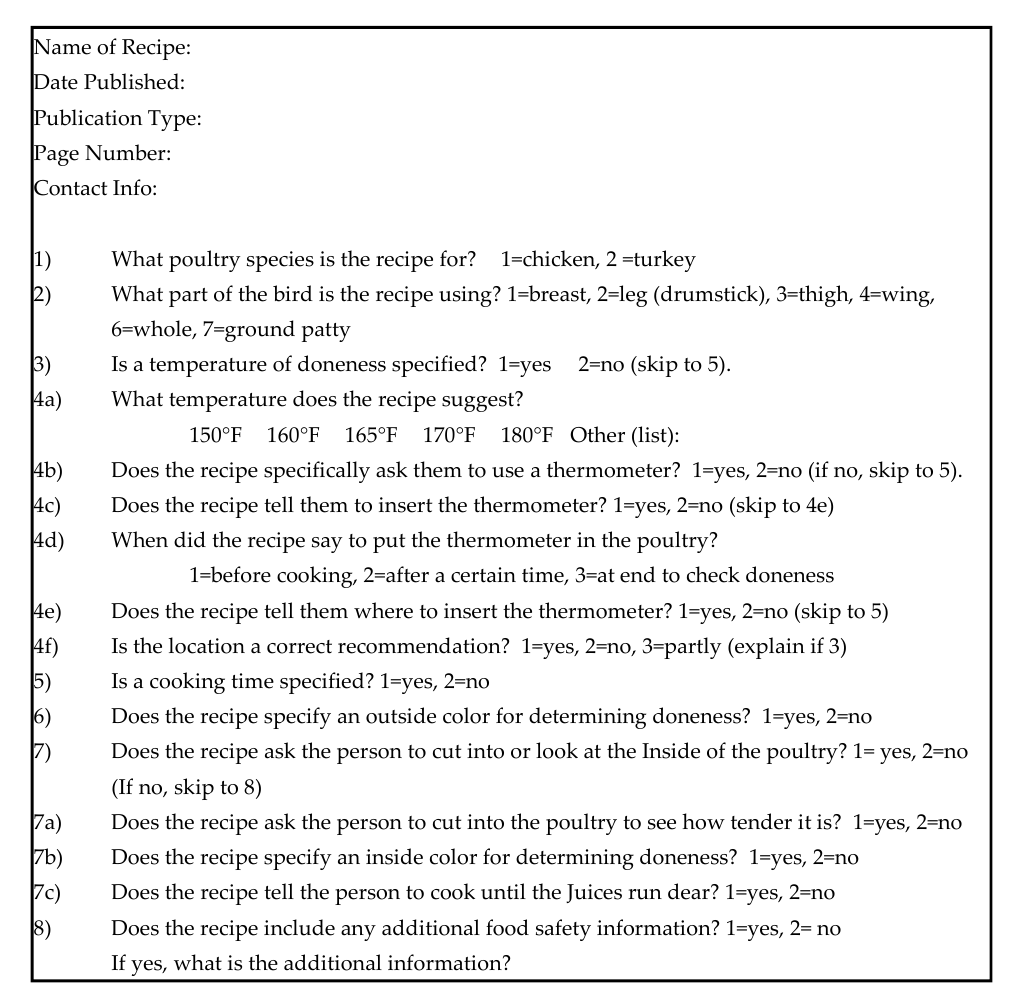
Figure 1. Checklist for evaluating recipe information related to doneness.